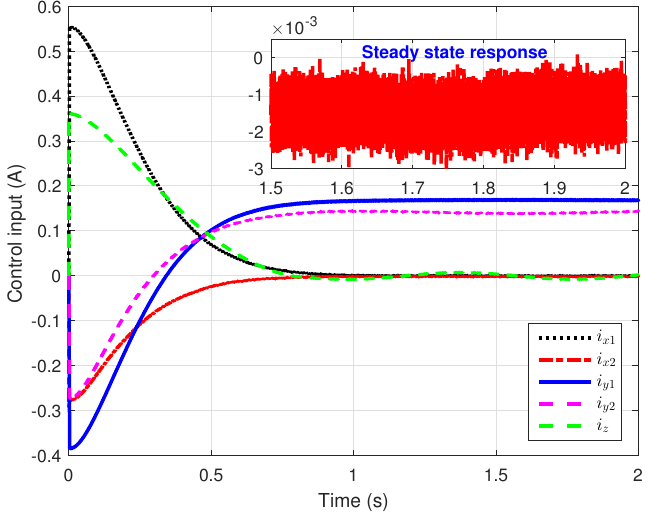
Figure 3. Time response of control inputs using AITOSMC. The adaptive gains for the proposed controller are plotted in Figure 4. The adaptive estimation gain ˆ α settles to the value of 2300.6 within 0.8 s and the other adaptive parameter ˆ β reaches to the estimate of 3.2 × 10 − 3 within 0.8